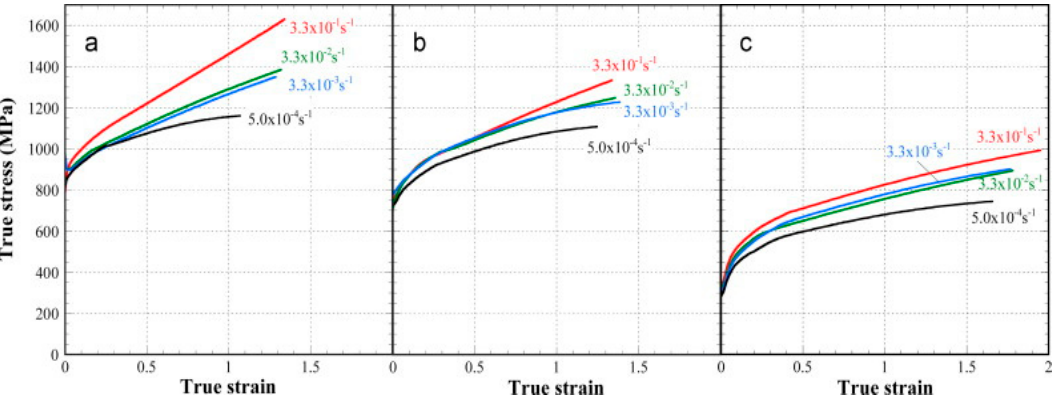
Figure 5. True stress–strain curve of the ferrite-cementite (FC) steels with ( a ) ferrite grain size of 0.5 μ m, ( b ) ferrite grain size of 0.8 μ m, and ( c ) ferrite grain size of 34 μ m at different strain rates [58] .